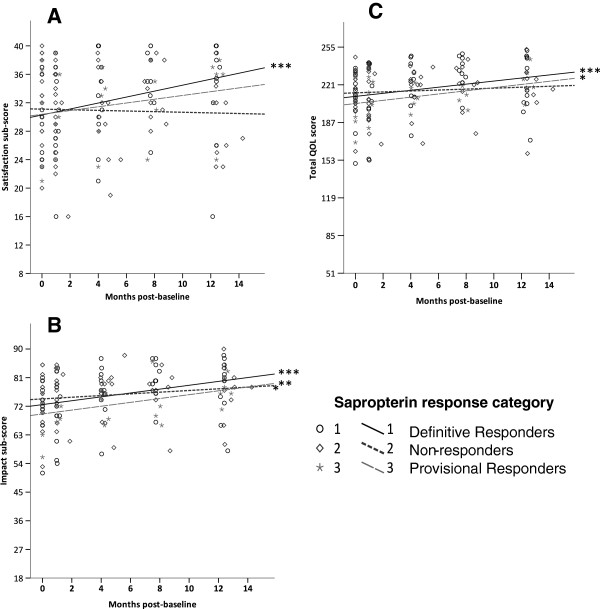
(A,B,C): Impact and Satisfaction sub-score (A and B) and total QOL (C) trends across one year. *p < 0.05, **p < 0.01, ***p < 0.001. p-values for longitudinal trends are age adjusted. Y-axis begins at minimum score.